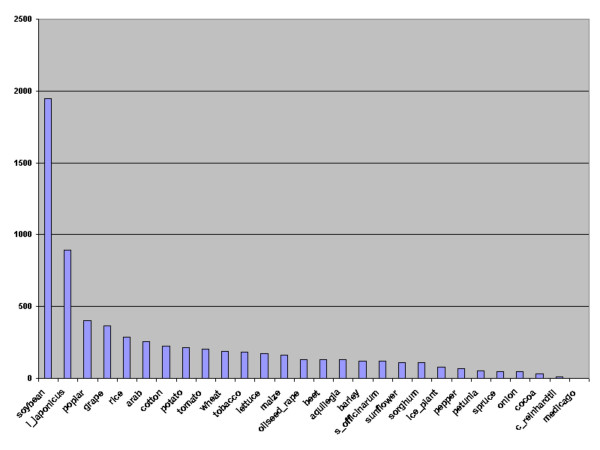
Matches of 53,796 unique sequences without a MtGI hit to other TIGR Plant Gene Indices.